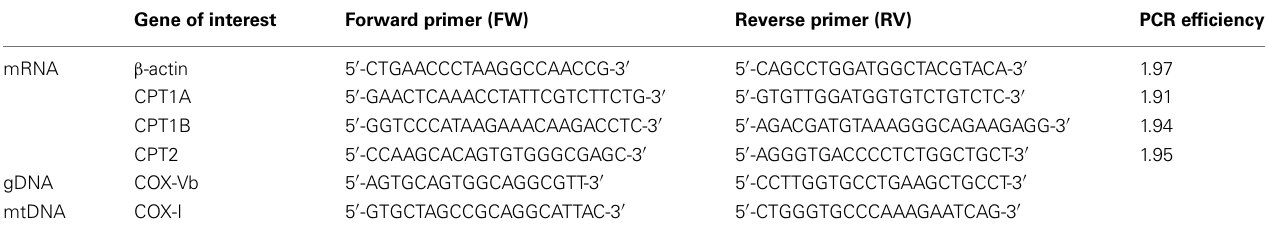
Table 1 | Primer sequences used in RT-PCR quantification of mRNA and DNA. Gene of